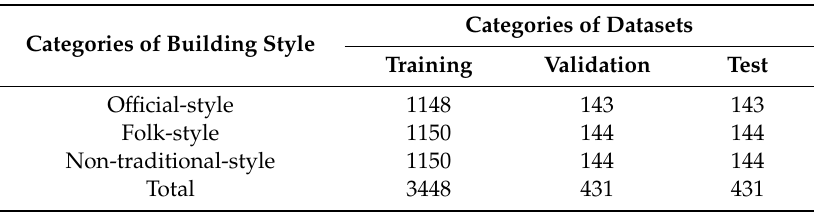
Table 2. Description of